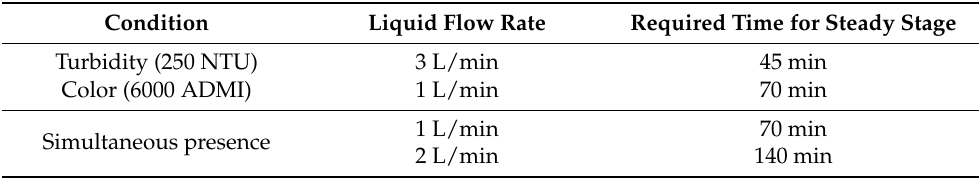
Table 3. Summary the treatment condition requirement to reduce to the target